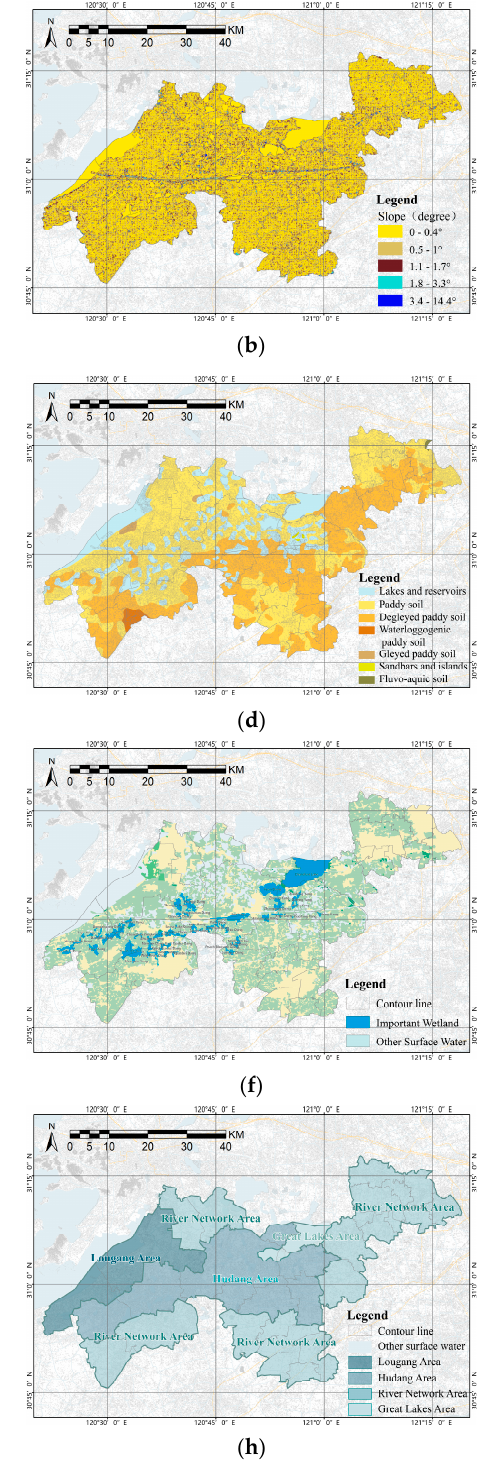
Figure 4. Natural basement analysis of the demonstration area. ( a ) Elevation analysis; ( b ) slope anal- ysis; ( c ) water networks analysis; ( d ) soil analysis; ( e ) distribution of important lakes and Dang; ( f ) distribution of important wetlands; ( g ) land use analysis; ( h ) landscape geographical feature divi- sions.